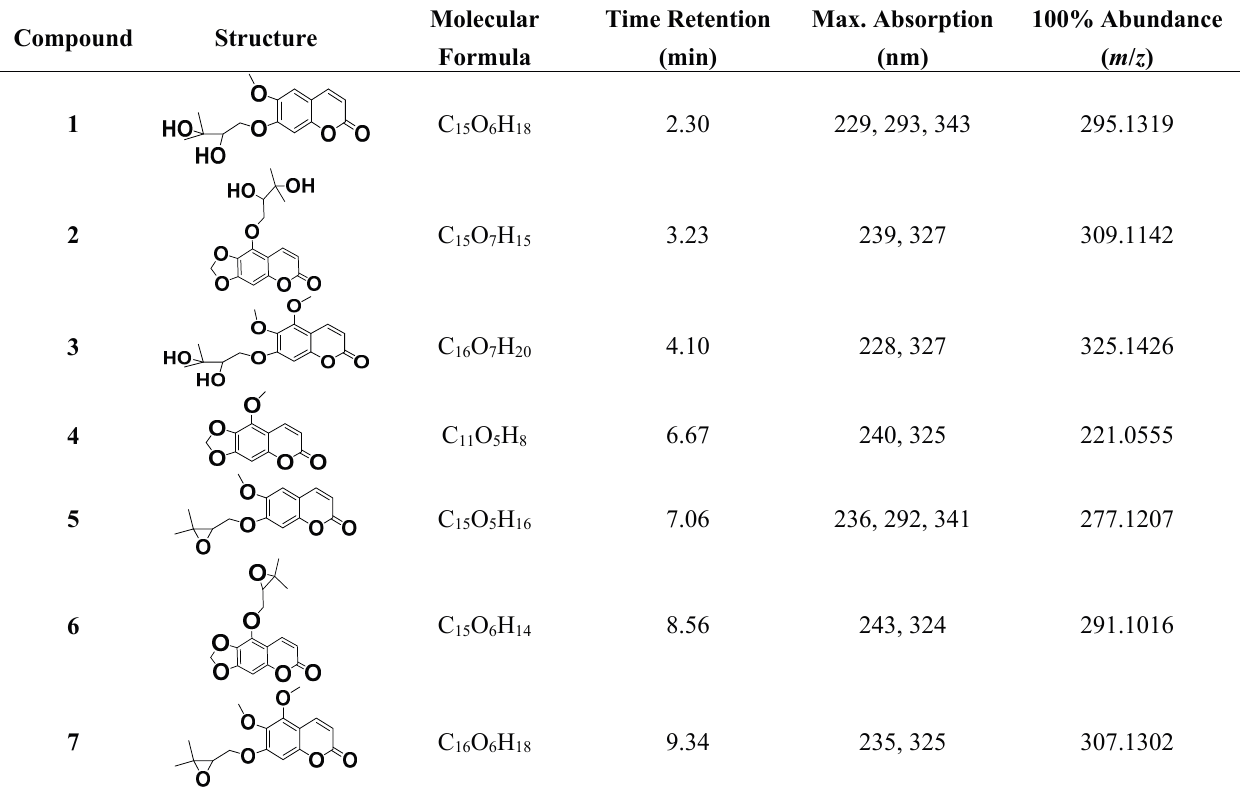
Figure 2. Chromatographic profile of the aqueous extract by UPLC method. Table 1. Relationship between the absorption maxima in the UV and maximum abundance in the ESI-MS for the compounds of the aqueous extract of P. balansae